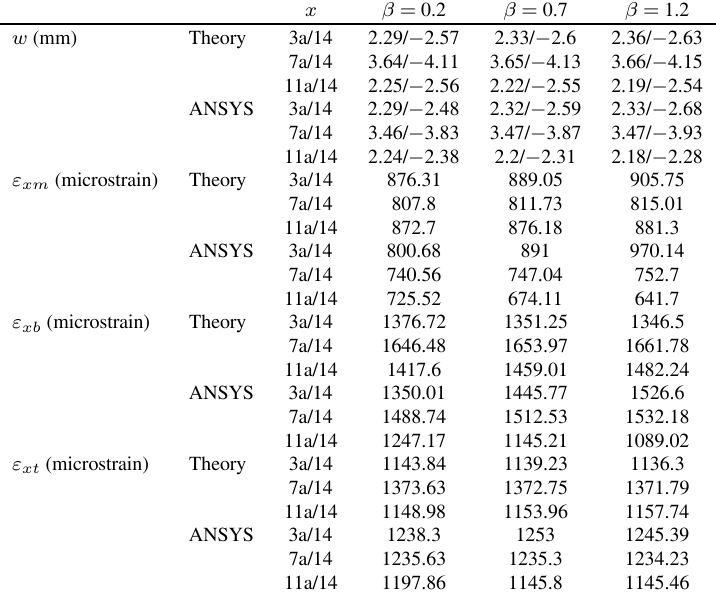
Table 4 Peak values of displacements and strains for different taper ratios and [UCBGBC] s